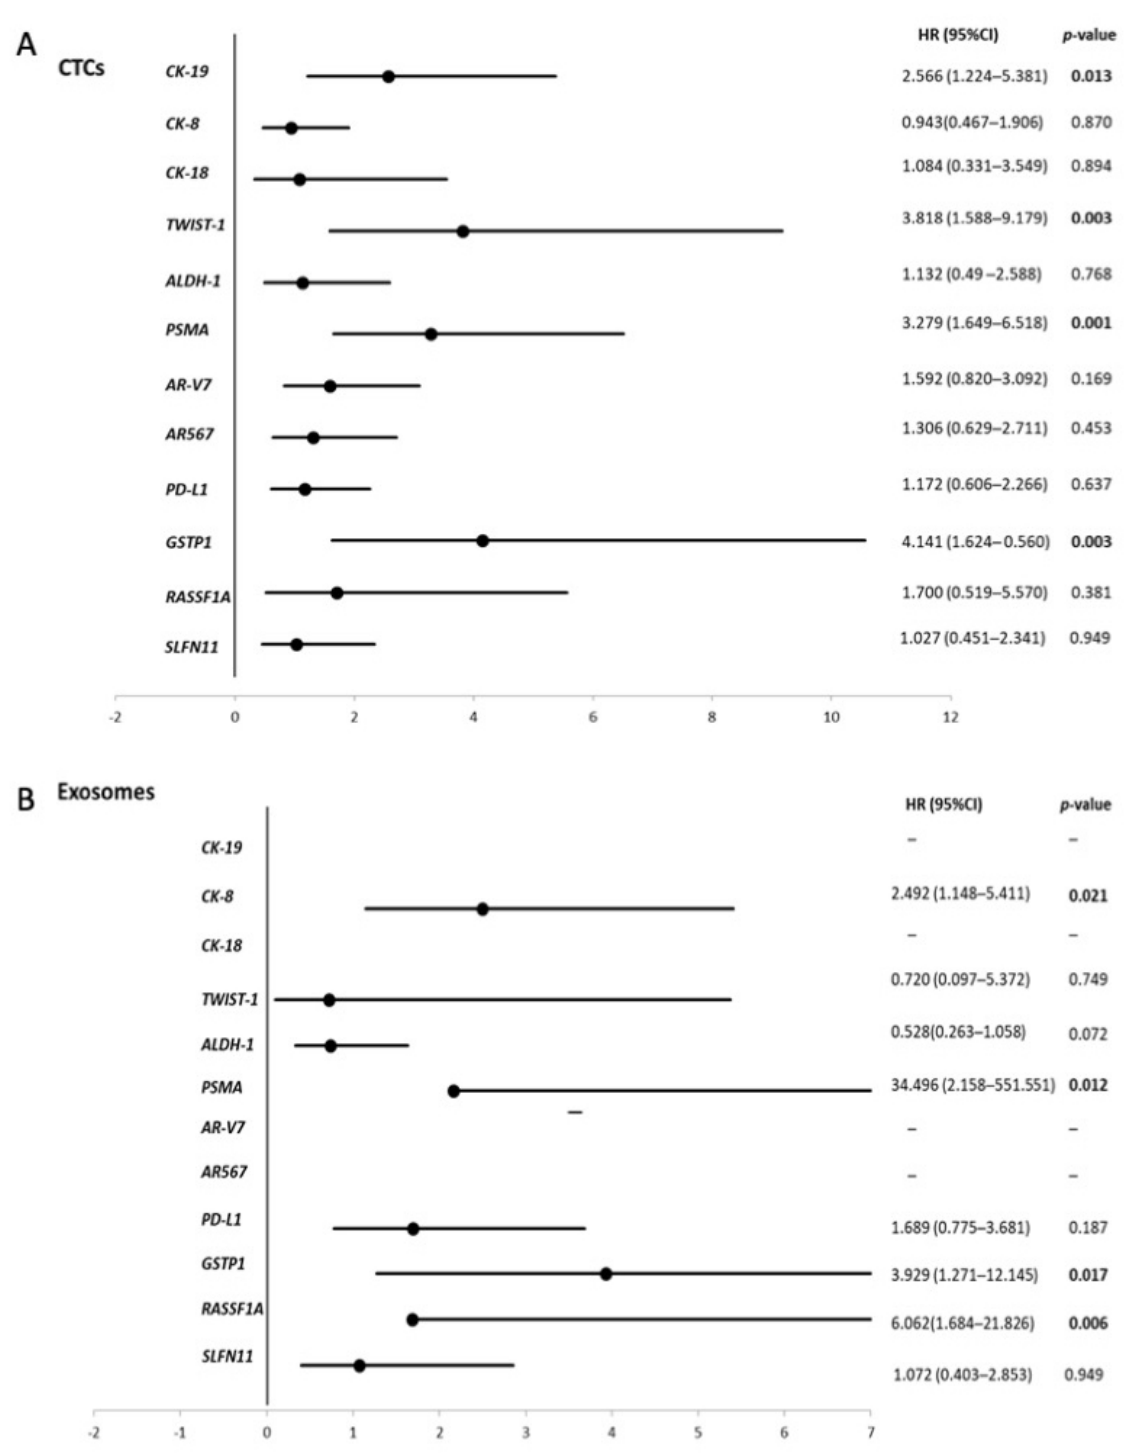
Figure 4. Forest plots of univariate Cox models for OS of mCRPC patients: ( A ) CTCs and ( B ) exosomes. Bold values denote statistical significance at p < 0.05